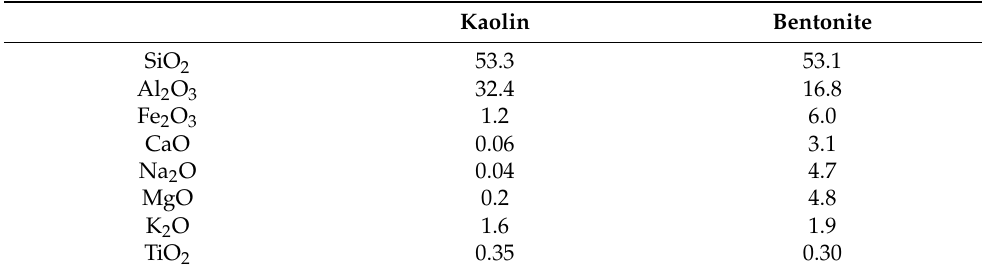
Table 1. Chemical composition of the binders.